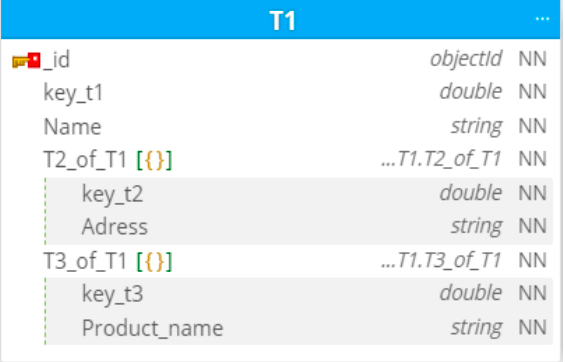
Figure 6. New collection with sequentially embedded documents.